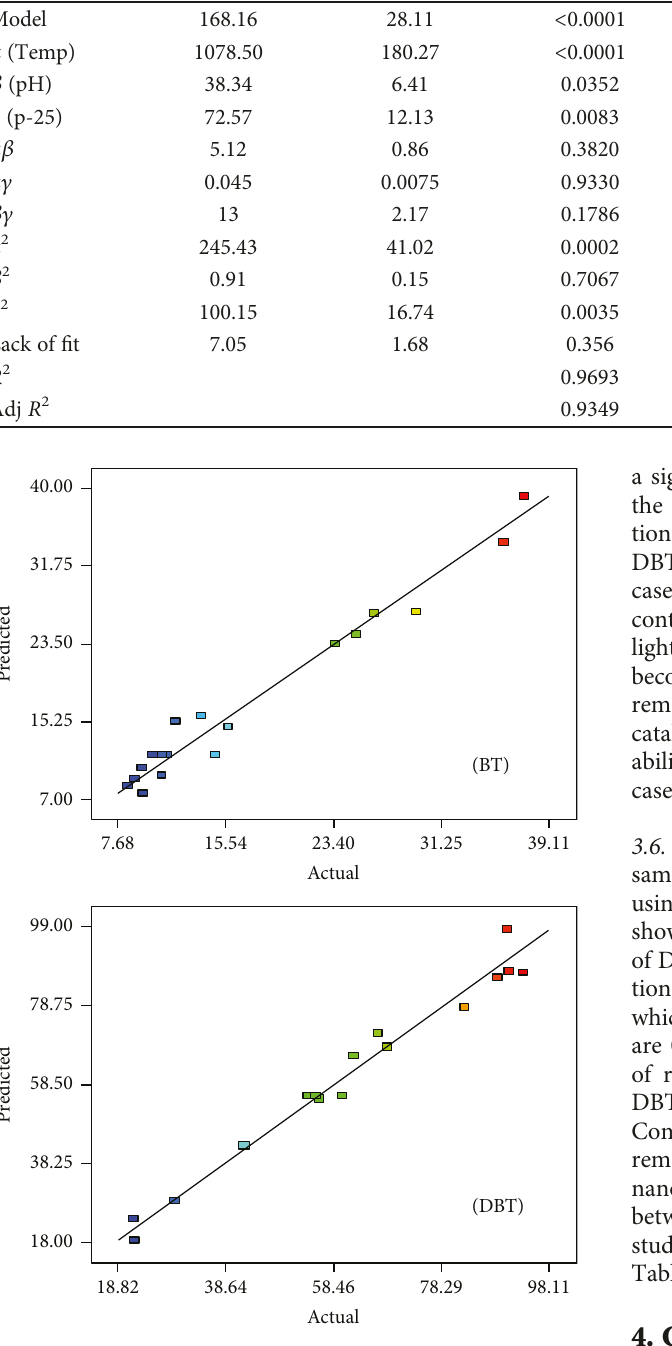
Figure 2: Predicted versus actual values for photooxidation of BT and